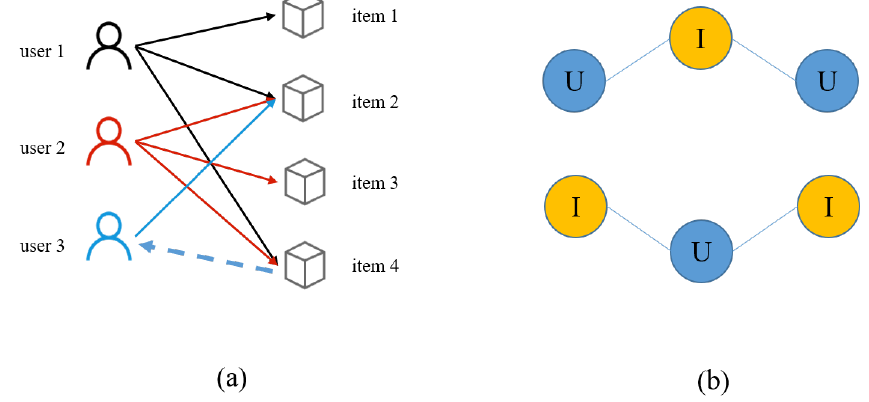
Figure 4. ( a ) An example of user–item interaction graph. ( b ) An example of